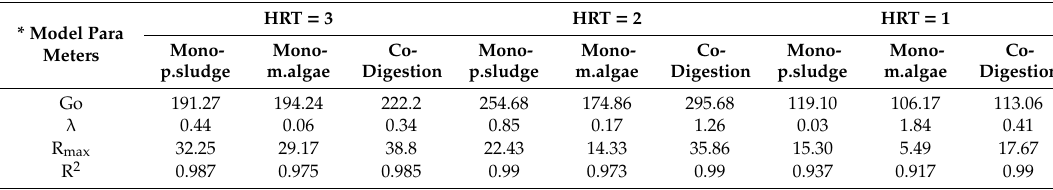
Table 3. Kinetic model parameters (after aerobic